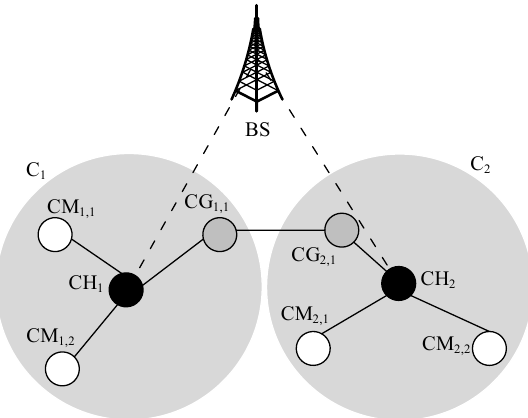
Figure 2. An example of a cluster structure in a traditional clustered network. Solid line represents the connectivity between a node pair, and dash line represents the connectivity between a CH and a